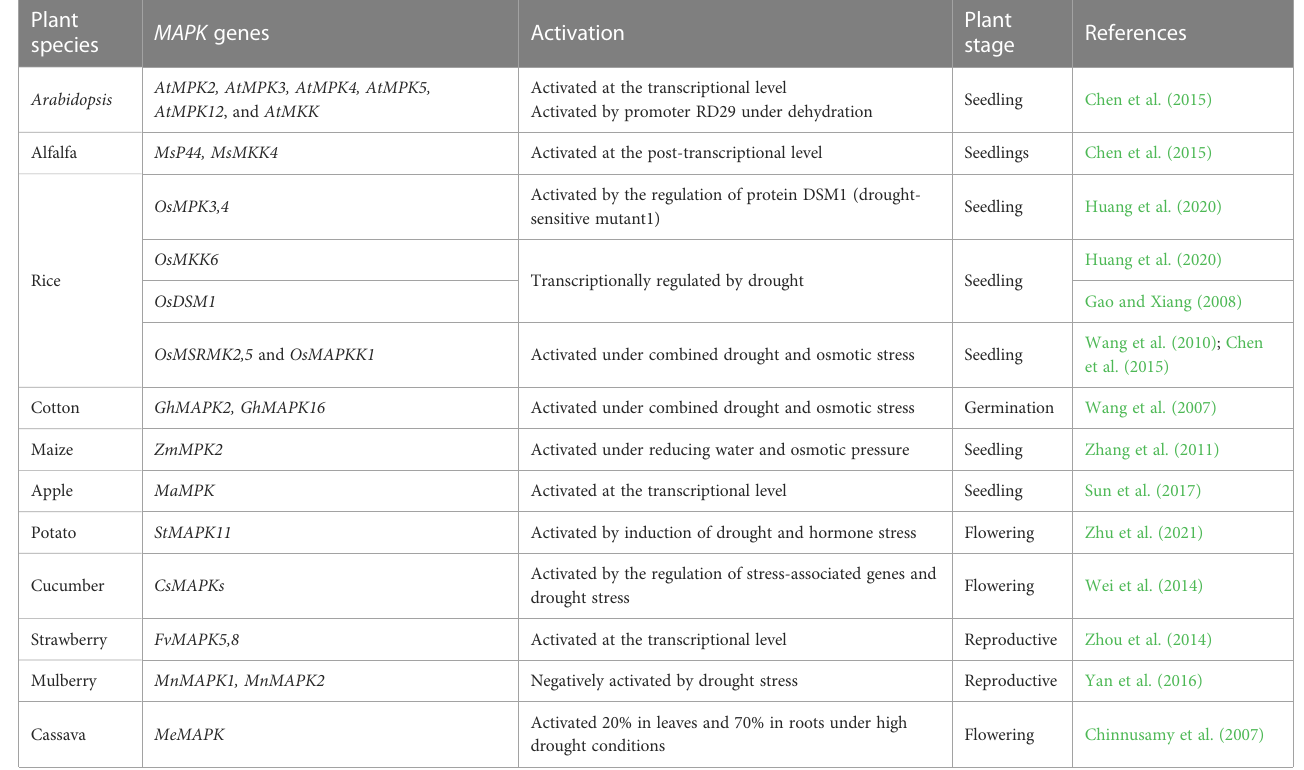
TABLE 2 MAPK gene signaling responses in different plants under drought stress